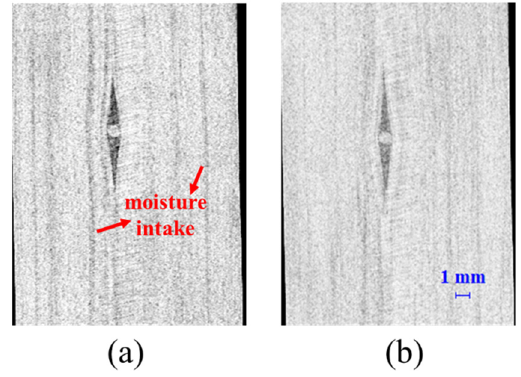
Figure 4: Microscopic morphology through the second direction of Z - pinned composite after ( a ) moisture for 7 days, and ( b ) moisture coupled with fl exural load for 7 days.